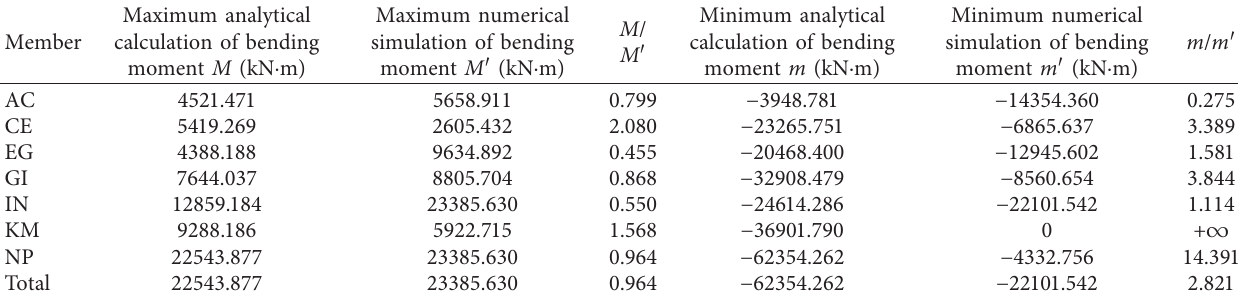
Table 7: A comparative table of the bending moments of the antislide members.